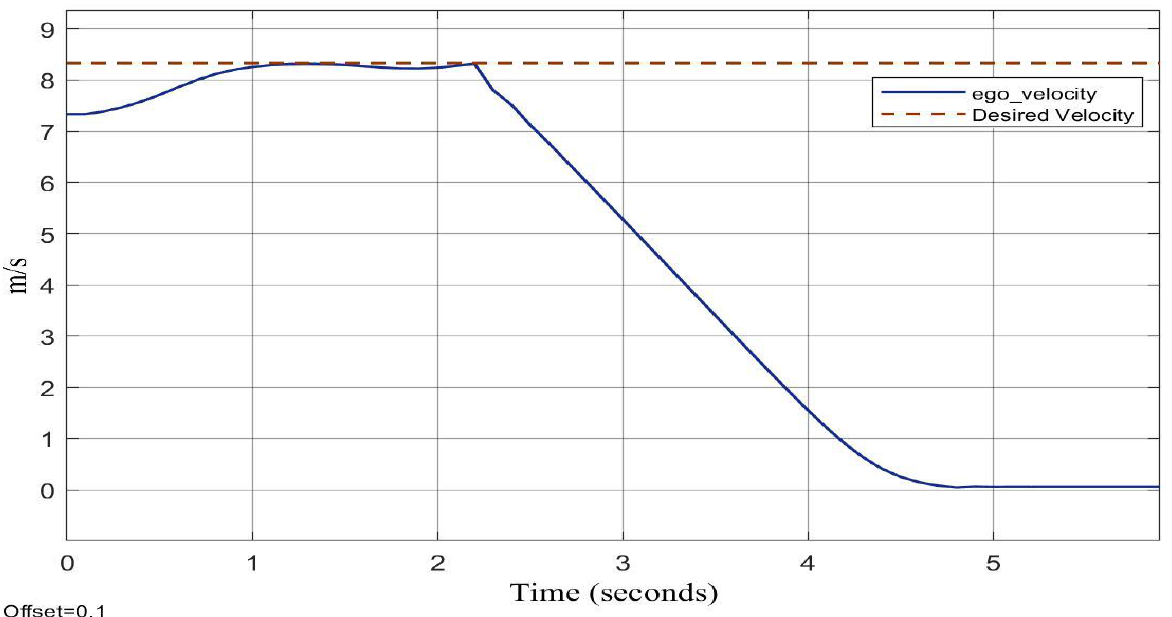
Figure 17. The velocity of the ego vehicle.